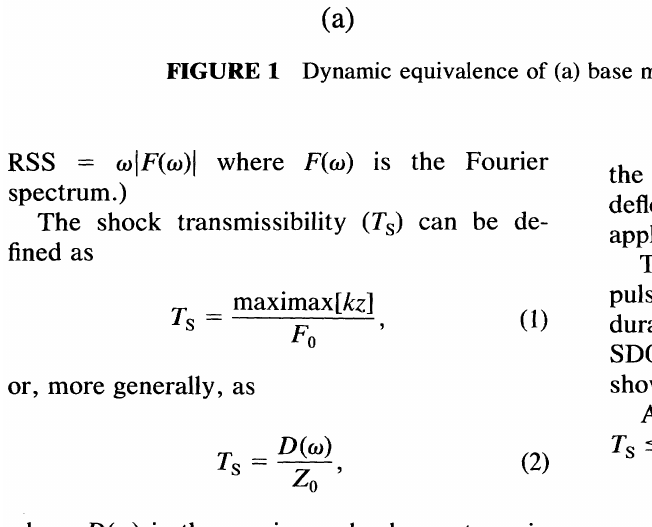
FIGURE 1 Dynamic equivalence of (a) base motion shock and (b) force shock.